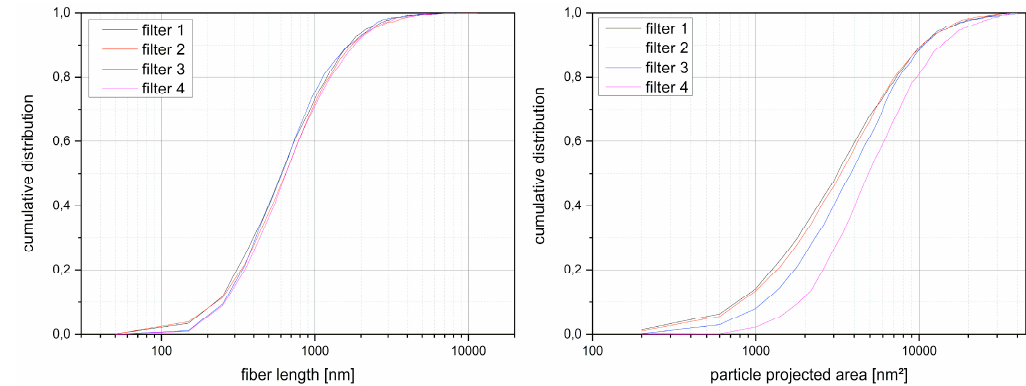
Figure 5. Cumulative length and projected area distribution of fibrous and non-fibrous particles.